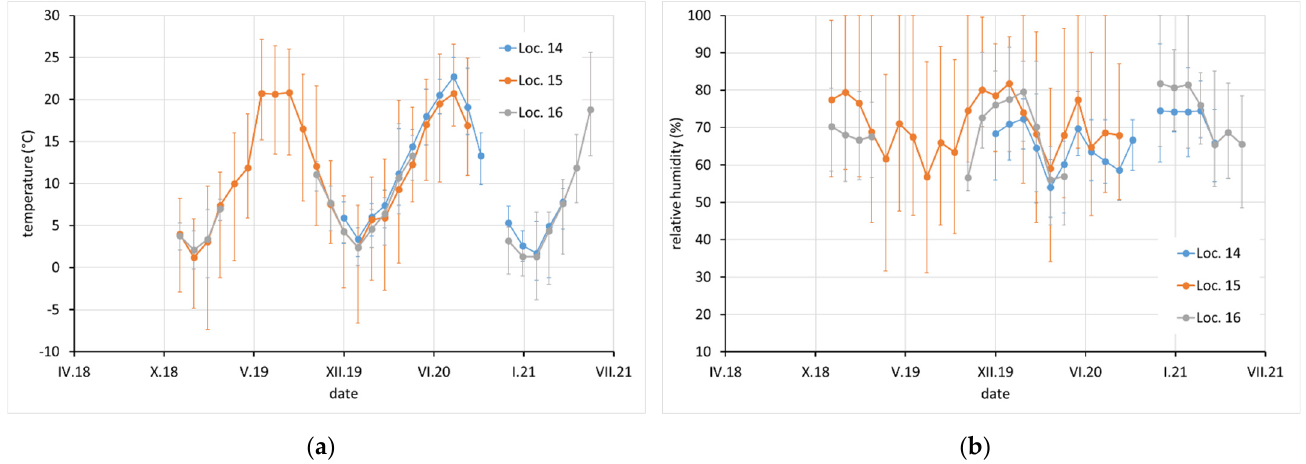
Figure 5. ( a ) Temperature and ( b ) relative humidity record at locations 14, 15, and 16. Points indicate average monthly values and error bars indicate monthly minimum and maximum.